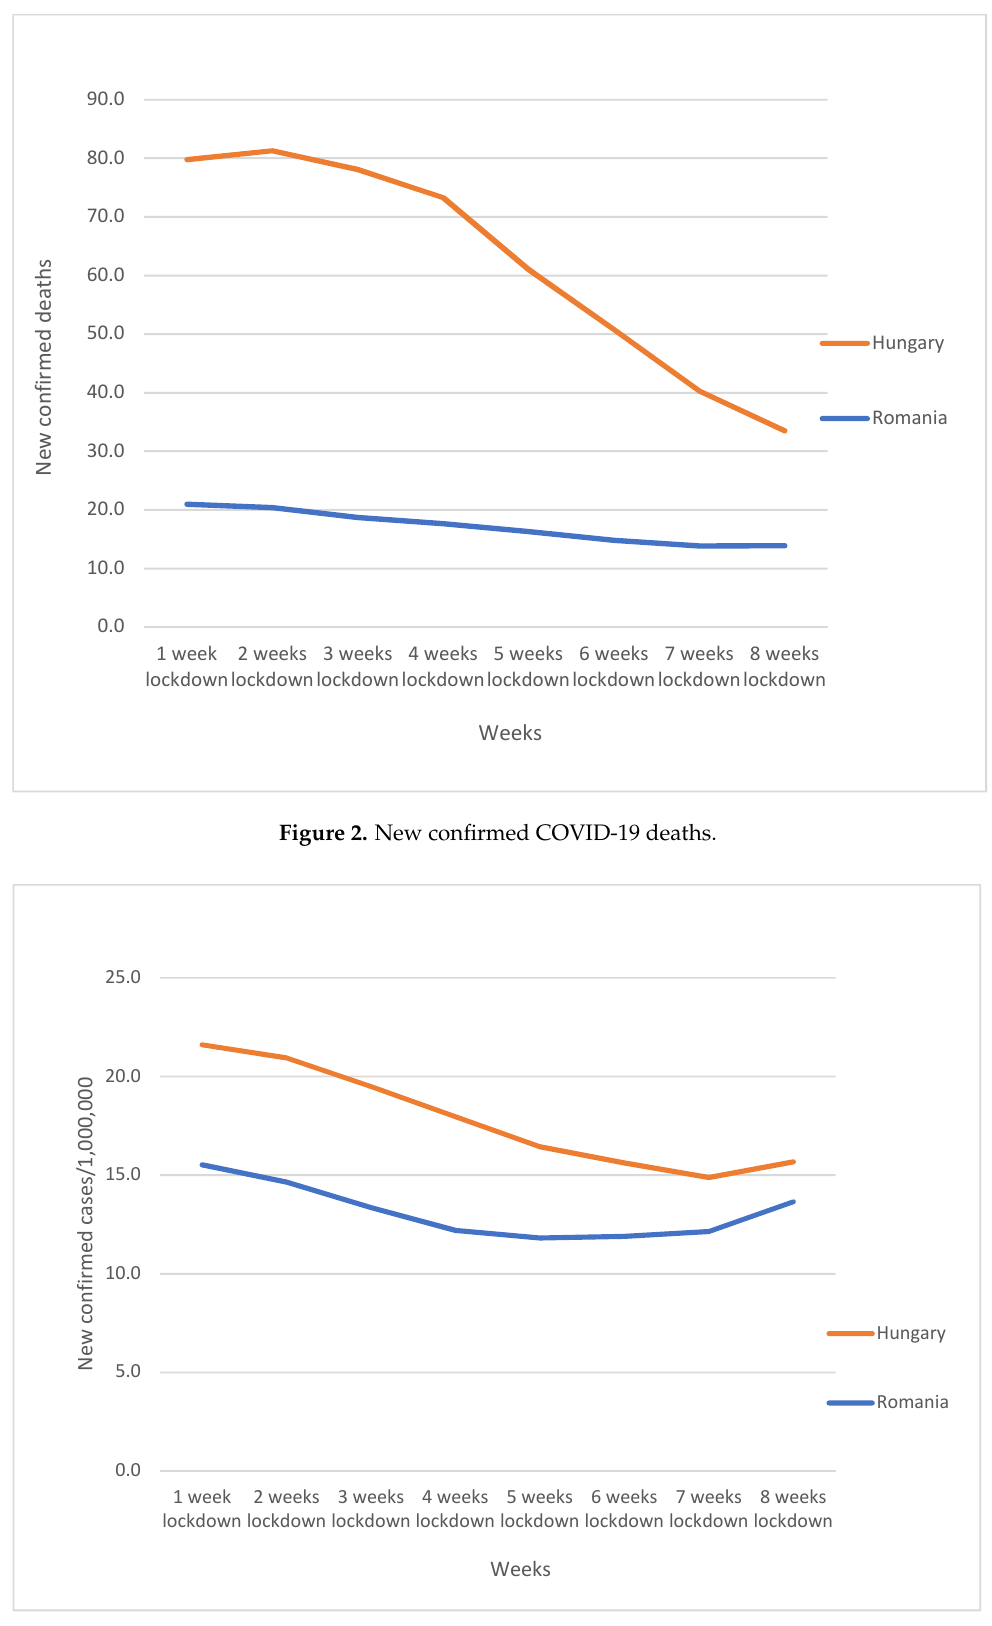
Figure 1. New confirmed COVID-19 cases.